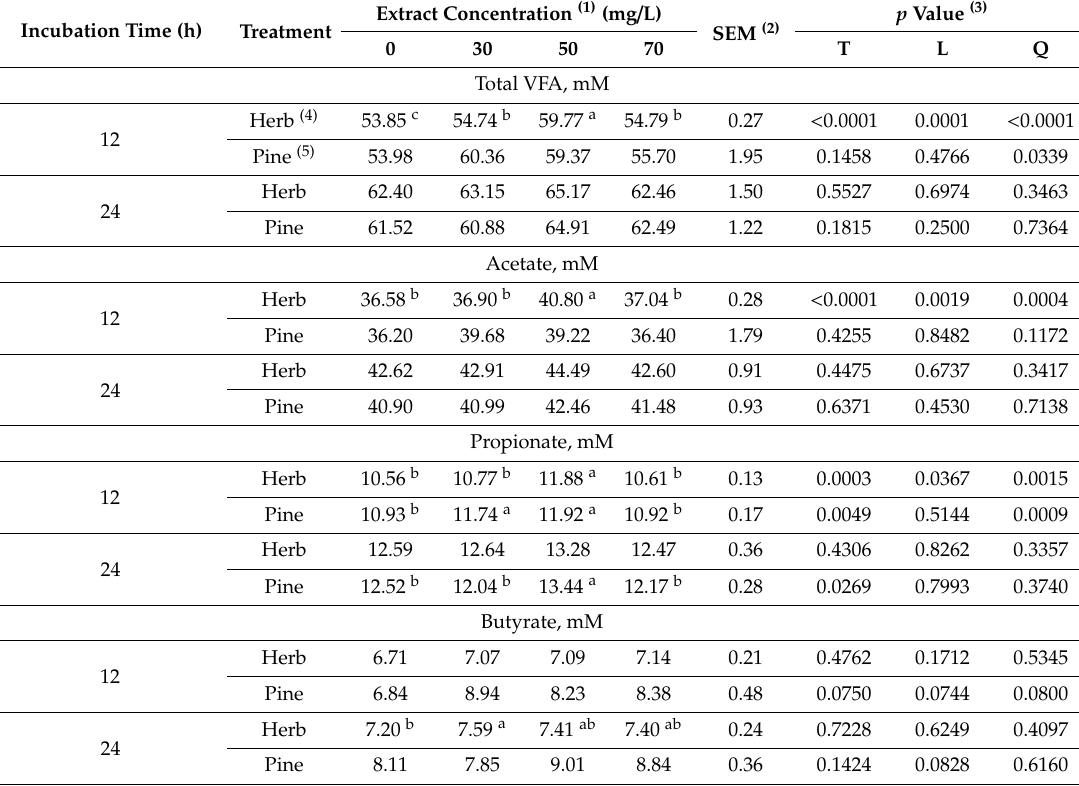
Table 5. E ff ects of terpene-based plant extract on VFA profiles after 12 and 24 h of in vitro